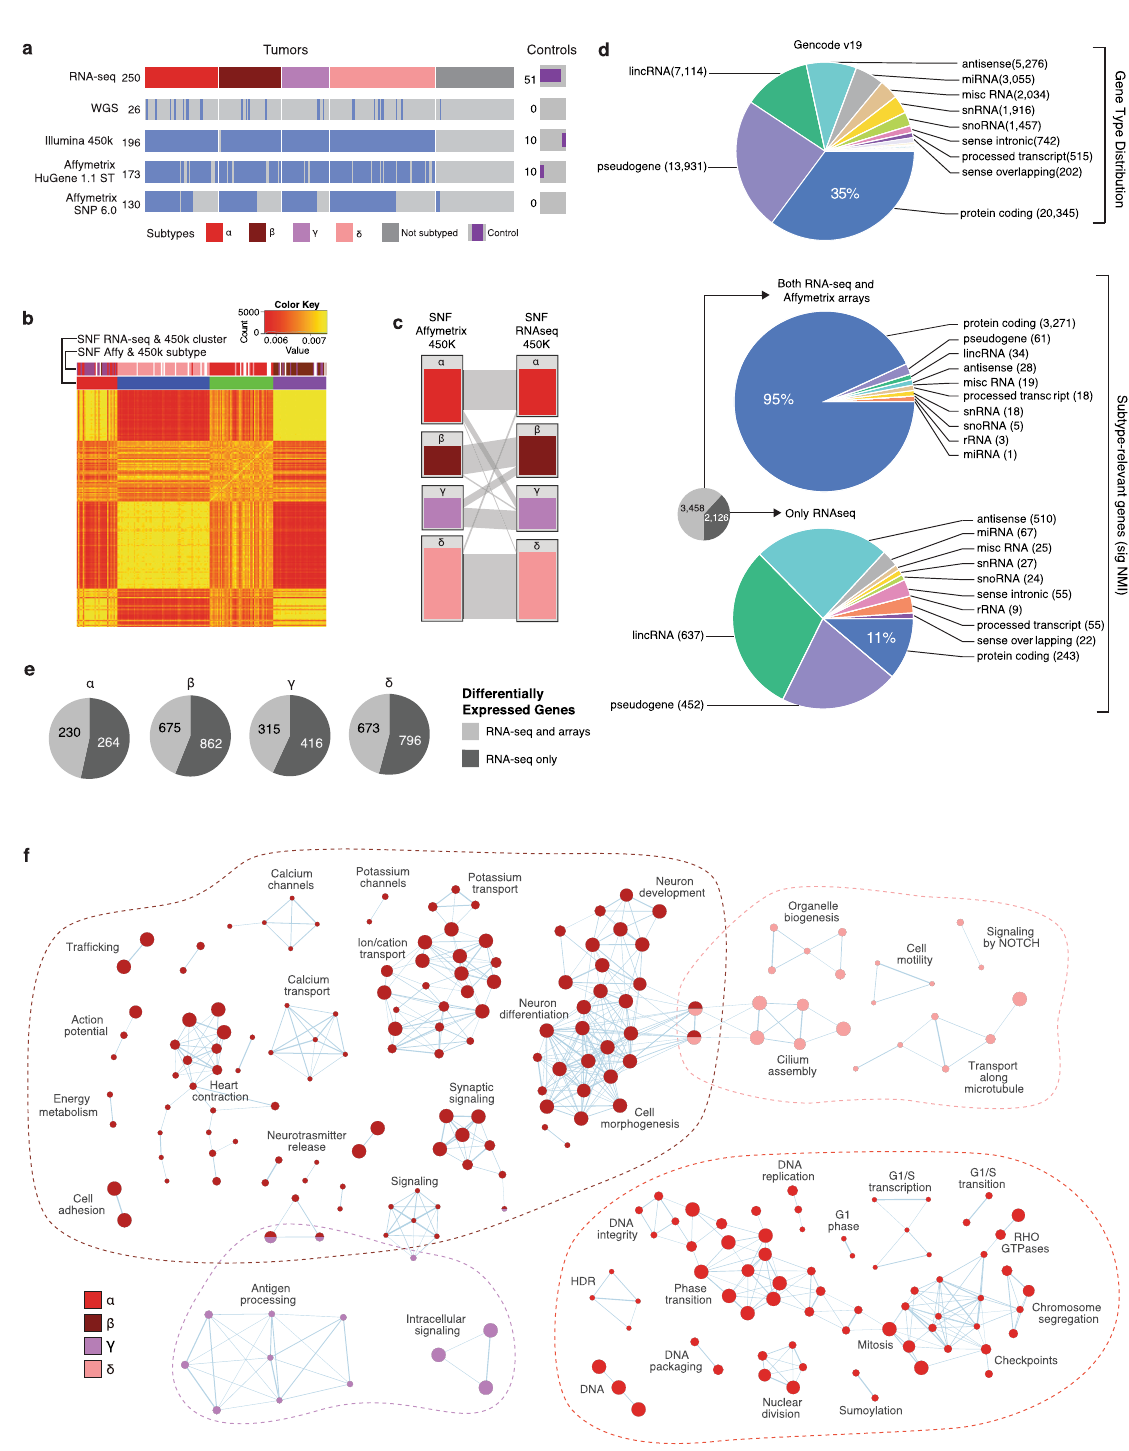
Fig. 1 Importance of the non-coding transcriptome in Shh-MB. a Overview of Shh-MB RNA-seq samples and overlapping data sources. b Heatmap of the sample-to-sample fused network (SNF) by cluster ( k = 4, n = 250). Sample similarity is represented by red (less similar) to yellow (more similar) coloring inside the heatmap. c Subtype clusters obtained by Similar Network Fusion ( k = 4) using Affymetrix expression + 450 K methylation and RNA-seq + 450 K methylation ( n = 196). Relationships between clustering methods are indicated by gray bars between columns. d Biotype distribution amongst all genes (top) as compared to genes that differentiate subtypes (signi fi cant normalized mutual information (NMI) from SNF RNA-seq + 450 K methylation), in both RNA-seq and microarray datasets (middle) or restricted to only the RNA-seq dataset (bottom). e Differentially expressed genes per subtype (RNA- seq). Genes found only with RNA-seq data are indicated. f Enrichment map of biological processes and pathways in Shh-MB subtypes. Each node represents a pathway or process and connecting lines represent common genes between them. Nodes with many shared genes are grouped together and labeled with a biological theme. The color of the nodes refers to the subtype(s) in which the process is enriched. The size of the node is proportional to the number of genes in the